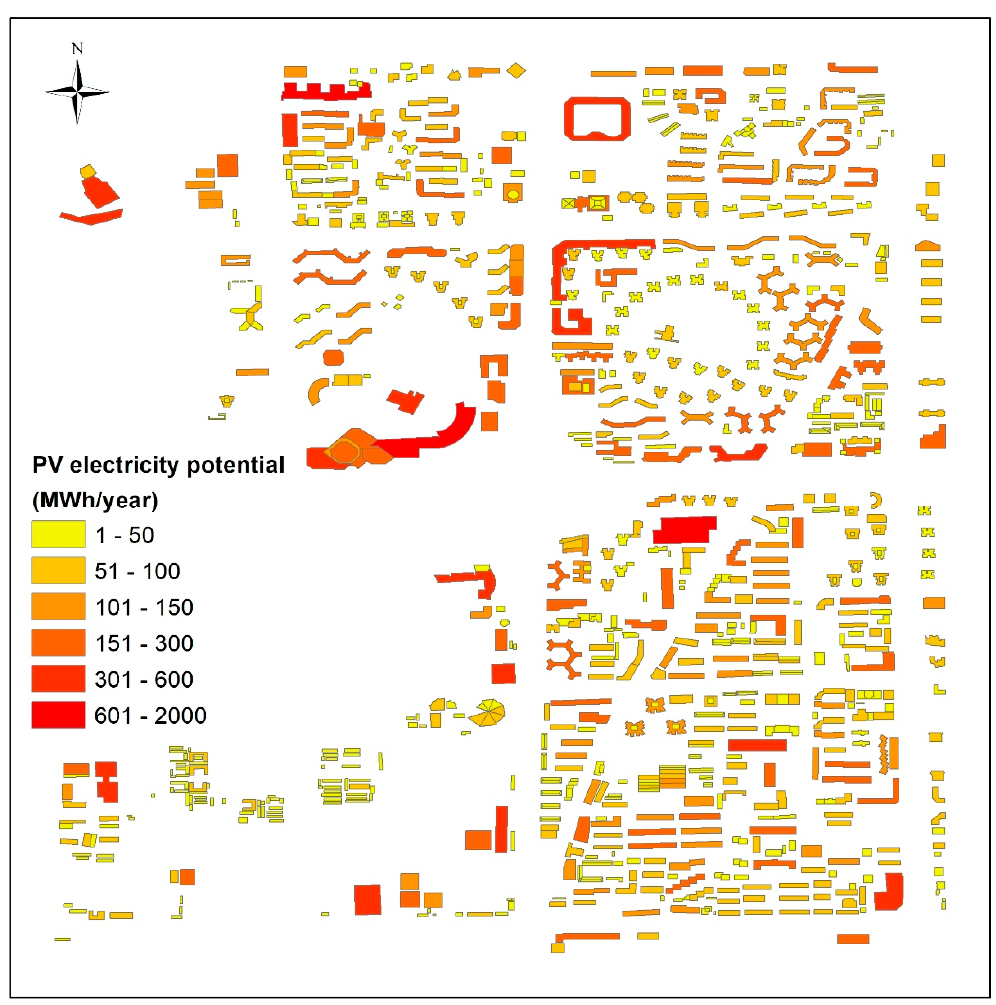
Figure 6. Annual PV potential map in study area.